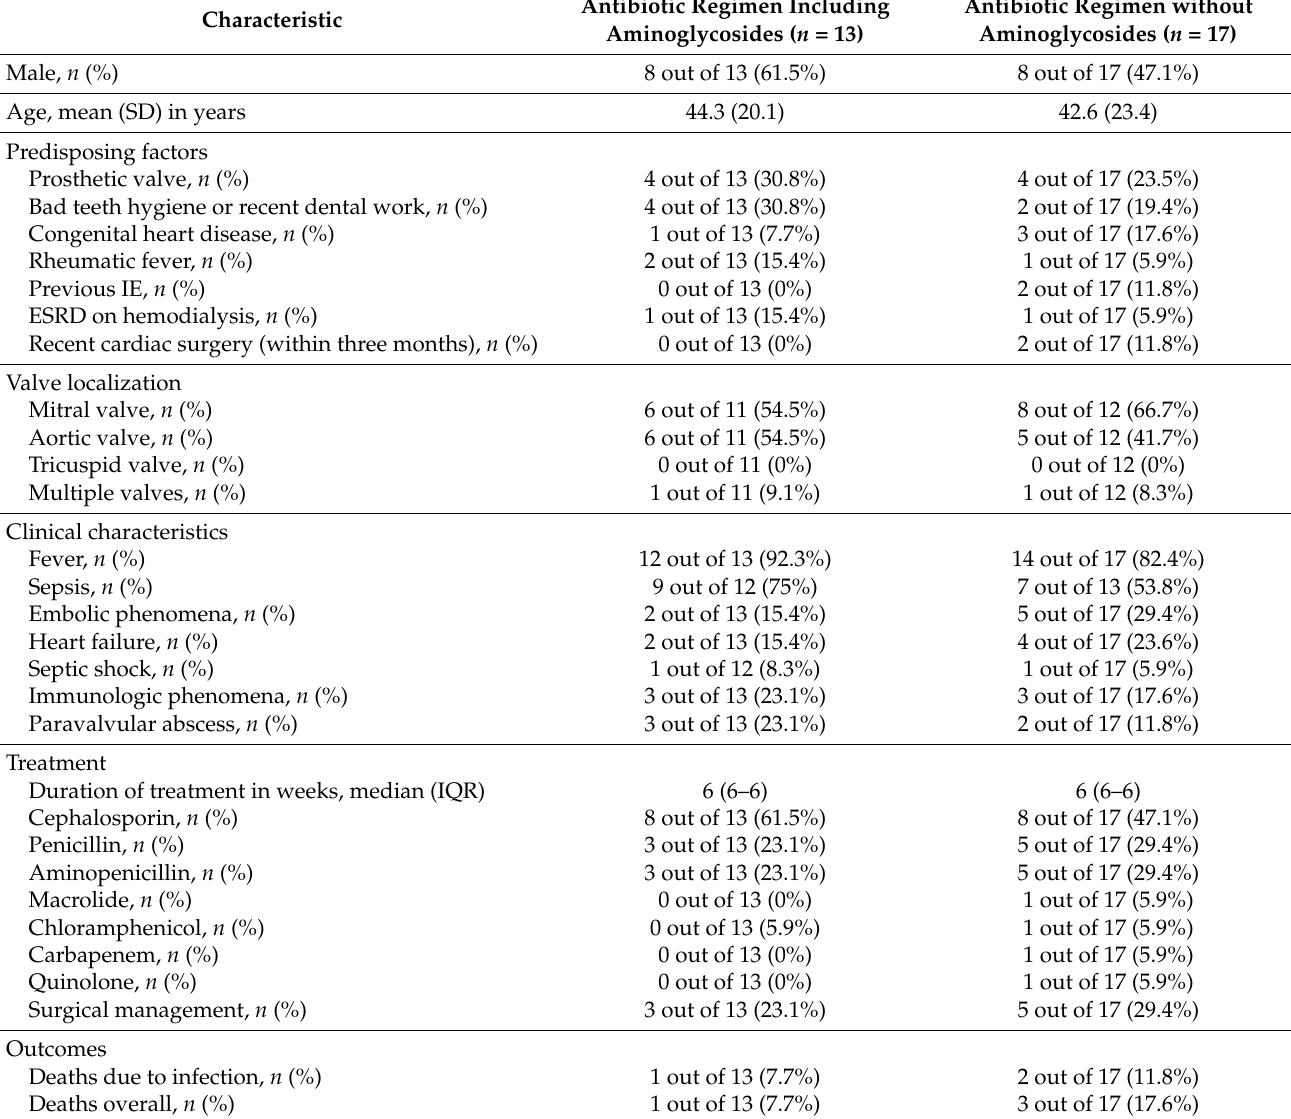
Table 2. Characteristics of patients with Infective Endocarditis by Moraxella spp. in regard to antimicrobial treatment. Values show cases among patients with available